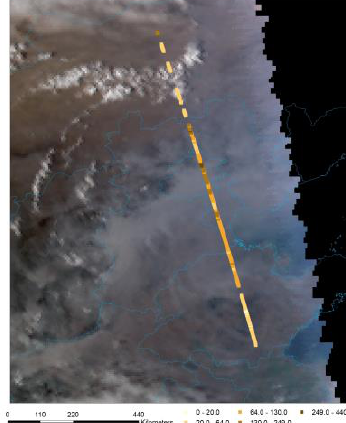
Figure 2. The satellite image overlayed by the PM 2.5 mass concentration on October 5 th ,